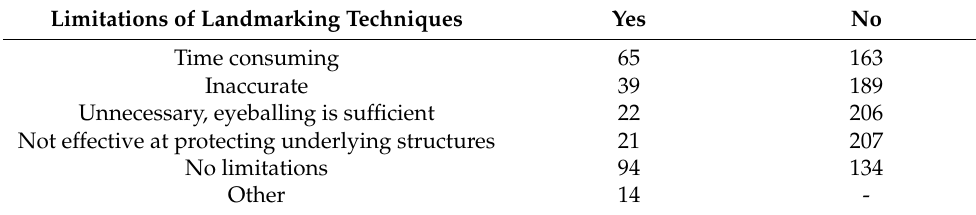
Table 7. Respondent nominations of limitations of landmarking techniques.